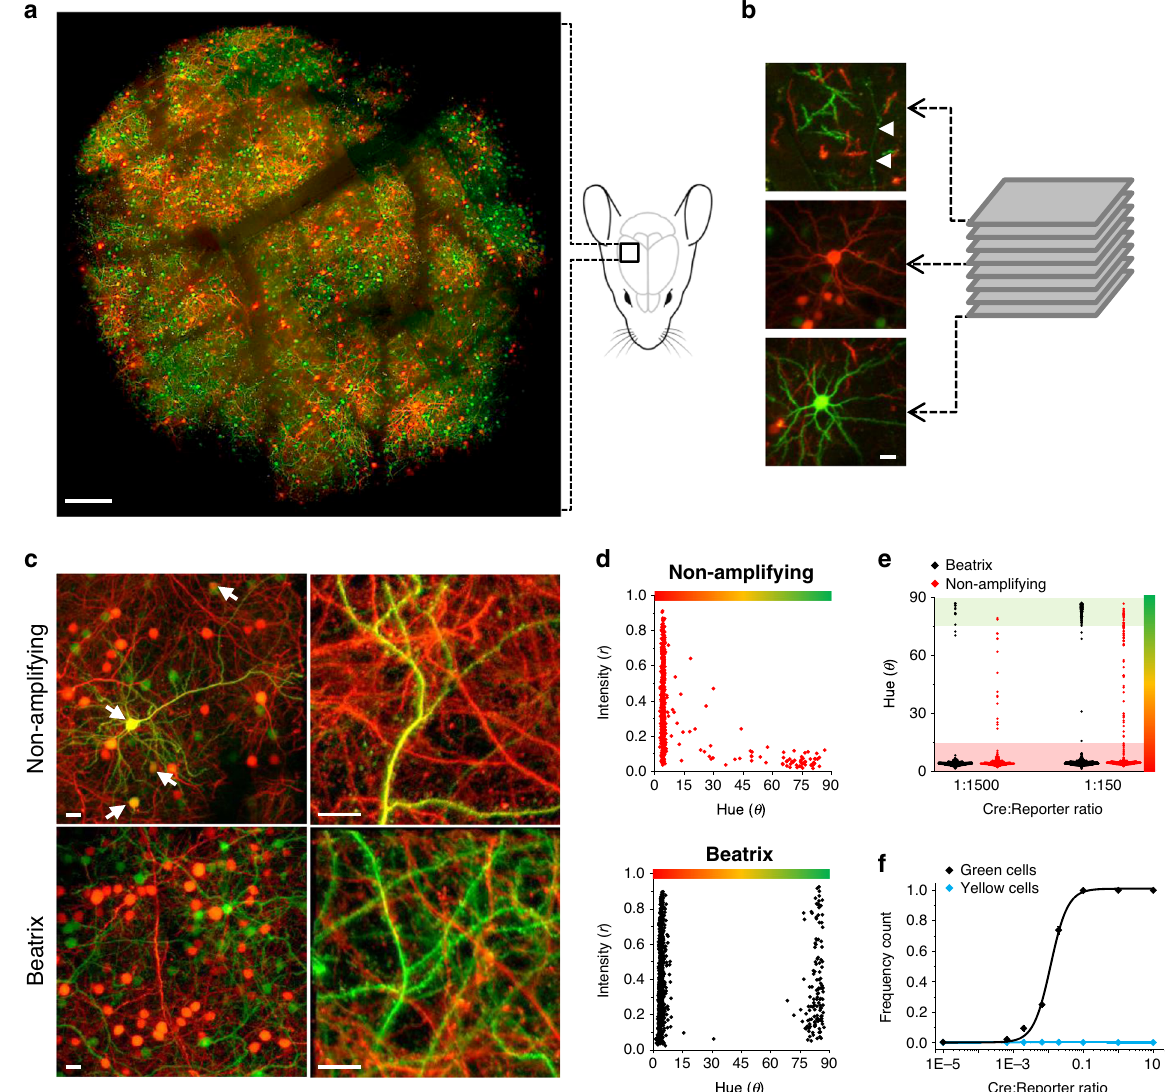
Fig. 2 In vivo expression mosaics induced with Beatrix or with a conventional reporter. a Wide- fi eld mosaic showing the entire area enclosed by the cranial window. The image obtained at P30 is a composite maximum projection of a stack imaged every 10 μ m from the surface down to about 250 µ m depth. Scale bar 200 µ m. b Details relative to fi elds placed at 25, 130, and 230 µ m depth. White arrowheads point to a super fi cial axon in layer 1 running through a fi eld of apical dendrites. Scale bar 20 µ m. c Representative fi elds of expression mosaic obtained with a Cre:Reporter ratio of 1:150. Arrowheads indicate cell bodies expressing both RFP and GFP that are frequent in the mosaic obtained without Cre ampli fi cation. In absence of ampli fi cation, dendrites show a uniform co-localization of GFP and RFP, which is absent in presence of ampli fi cation. Scale bar 20 µ m. d Cumulative data obtained from n = 4 mice transfected with Beatrix and Cre at the 1:150 ratio (864 neurons) and from n = 3 mice transfected with a non-amplifying reporter and Cre (609 cells); these plots show the effect of the ampli fi cation on binarization (polar angle θ ) and mean fl uorescence intensity (radial distance r). In absence of ampli fi cation, the strong negative correlation between intensity and hue is con fi rmed by Pearson correlation coef fi cient R = − 0.45 (two-sided F-test of overall signi fi cance for linear regression p < 10 − 4 ). The fl uorescence intensity of the recombined cells is larger and more broadly distributed with Beatrix ( p < 0.01, two-sided Kolmogorov-Smirnov test). e Scatterplot showing the difference in hue variation upon a tenfold dilution of the Cre controller using either Beatrix or the non- amplifying reporter. Cells show a very strong binarization only in presence of ampli fi cation. 1:1500 ratio ( n = 3 mice per group), 1:150 ratio ( n = 4, Beatrix; n = 3 control). f Frequency count of cells expressing only GFP (black) or both RFP and GFP (cyan) as a function of the Cre:Beatrix plasmid ratio. The number of yellow cells is negligible for every Cre:Beatrix plasmid ratio. Each point expresses mean ± SEM of all animals for that condition and its standard error; n = 3 – 4 animals per point, each one 300 – 500 acquired projection, the images of red and green cells can overlap and acquired in vivo at P30 after IUE with Cre and either the non- produce yellow patches that are not an indication of erroneous amplifying reporter (upper images) or Beatrix (lower images) at recombination. All the quanti fi cations provided have been 1:150 molar ratio. We assessed these mosaics by quantifying the fl uorescence signal of each neuron in the green and red chan- obtained by analyzing single optical sections (~1 μ m thickness) imaged at high magni fi cation, allowing single-cell resolution nels (Fig. 2d). In absence of ampli fi cation, mosaics are affected analysis (Fig. 2b). Figure 2c shows representative fi elds of by the presence of partially recombined yellow cell bodies and neuronal mosaics in layer 2/3 (L2/3) of the occipital cortex dendrites, independently of the mosaicism level (Fig. 2d, e).